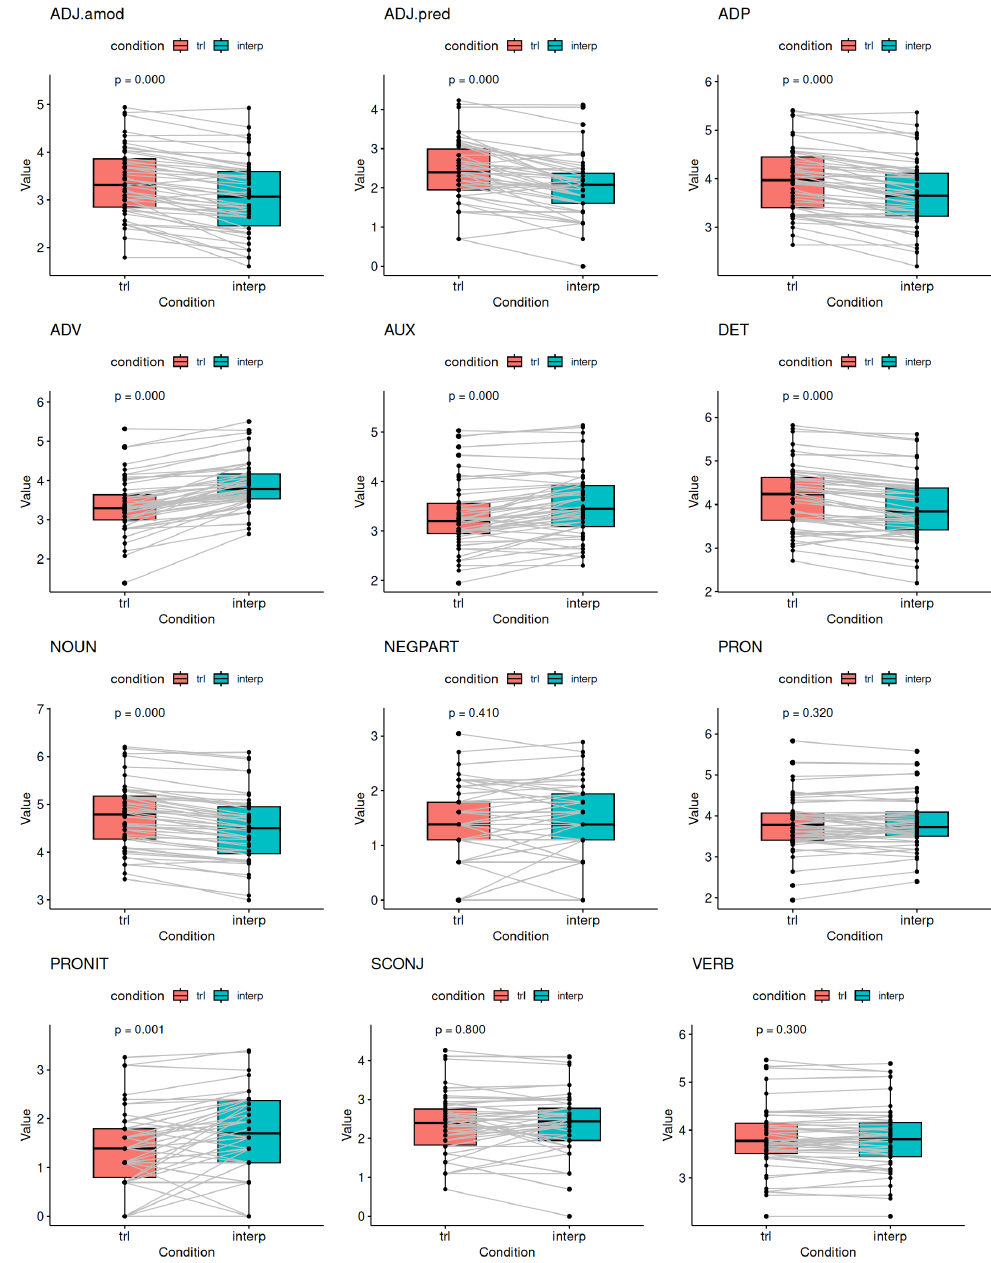
Figure 1. Pairwise comparisons of POS-frequencies (log-transformed) per speech in translations and interpretations. Each line connects data points representing the same speech (trl: translation, interp: interpretation).